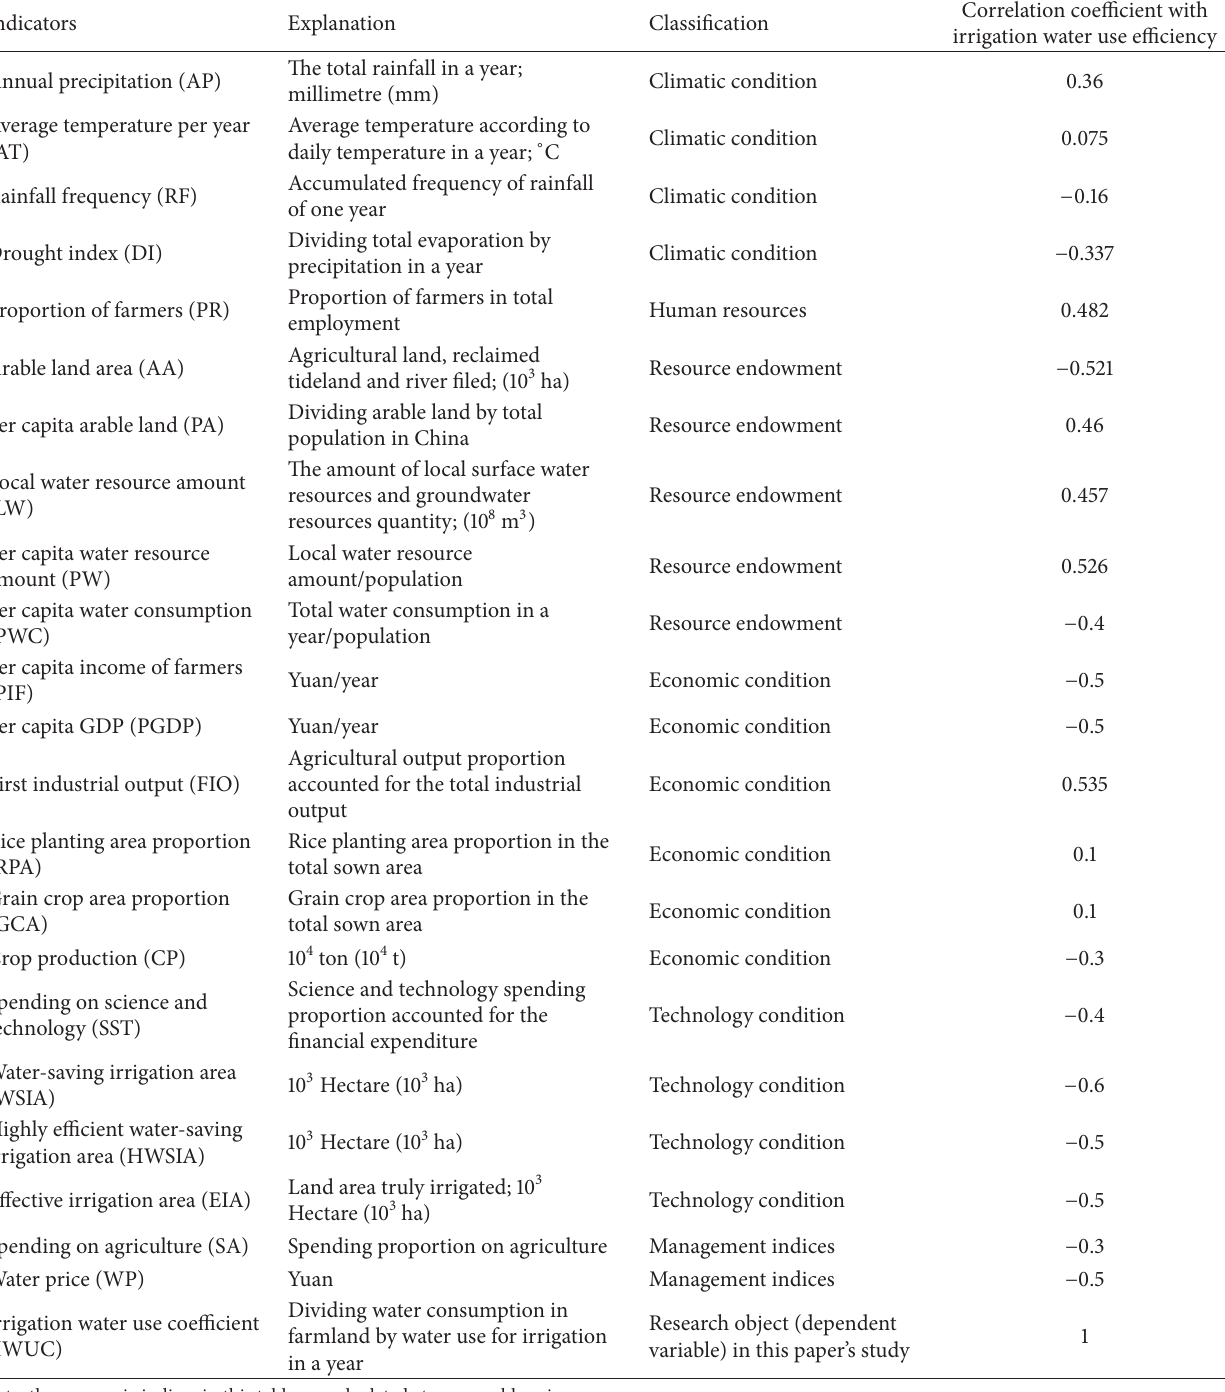
Table 1: Explanation of the selected driven factors.